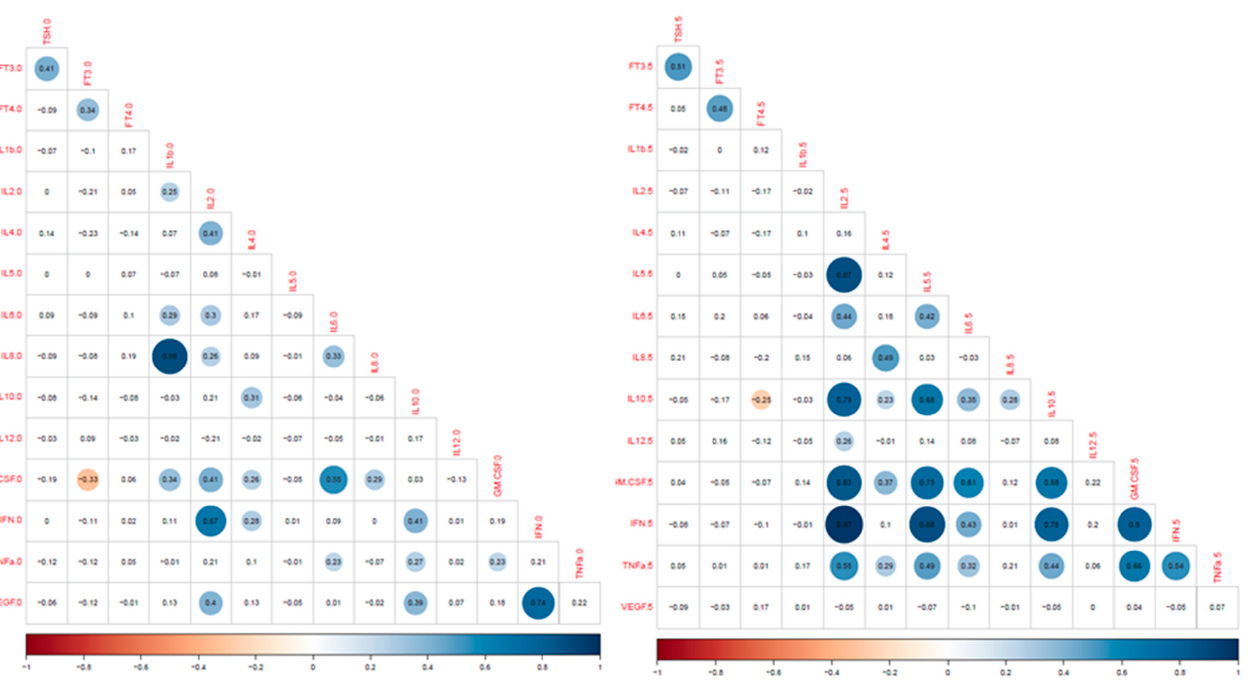
Figure 2. Scatter dots of correlations between TSH and cytokines at day 5 .